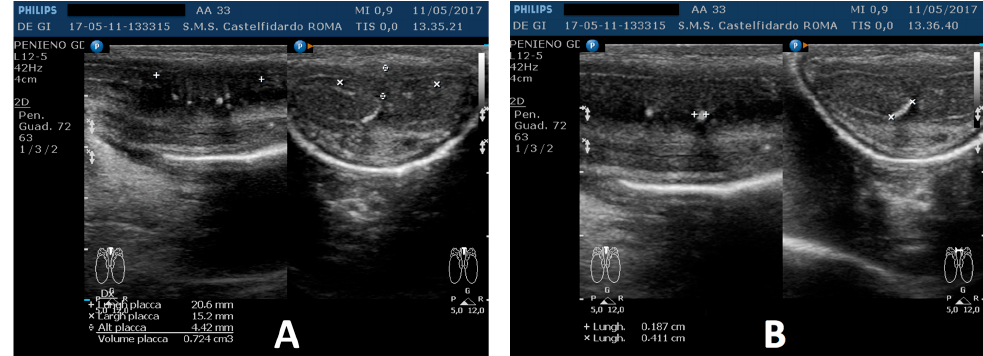
Figure 9. Ultrasonography of the penis before therapy (longitudinal and axial views). ( A ) Entire plaque; ( B ) the largest calcification.